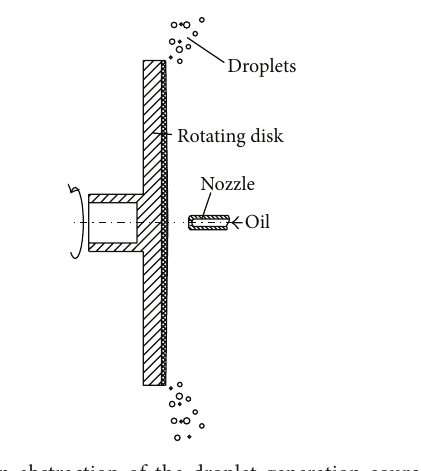
Figure 2: An abstraction of the droplet generation sources in a bearing